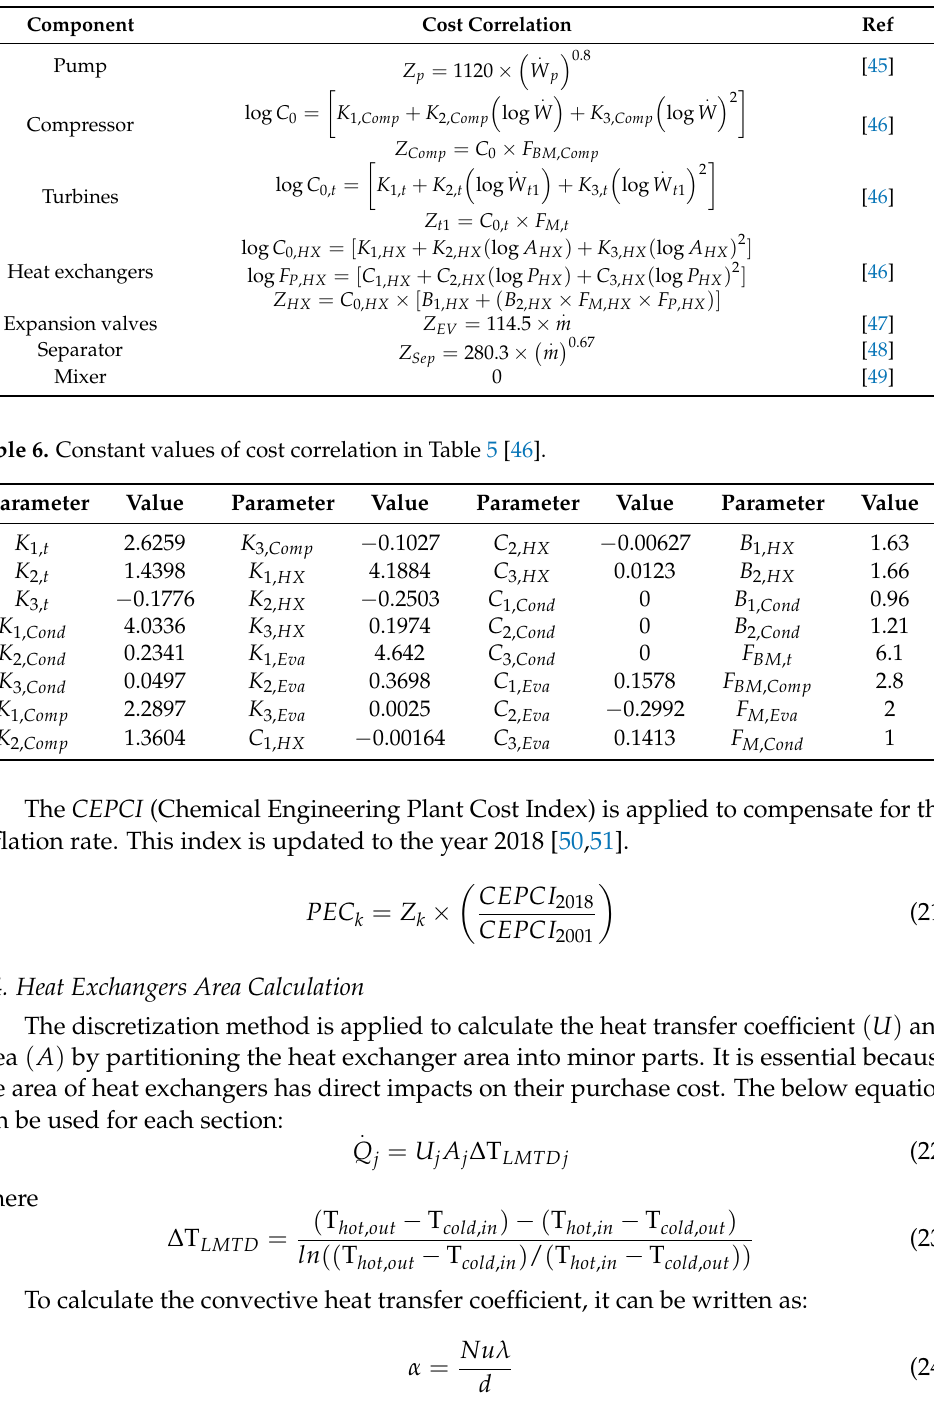
Table 5. The purchased equipment cost of all components.